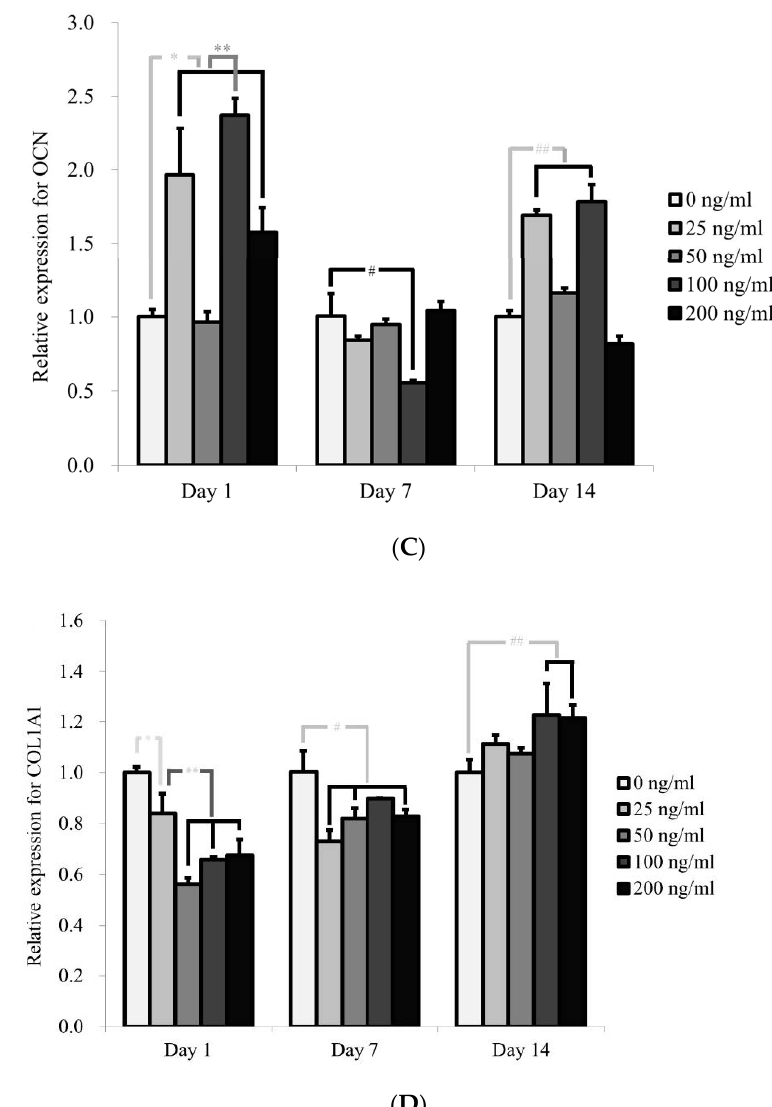
Figure 7. ( A ) Quantification of expression of RUNX2 mRNA by real-time polymerase chain reaction on Days 1, 7, and 14. * p < 0.05 vs. the 0 ng/mL group on Day 7. ** p < 0.05 vs. the 100 ng/mL group on Day 7. # p < 0.05 vs. the 0 ng/mL group on Day 14. ## p < 0.05 vs. the 200 ng/mL group on Day 14. ( B ) Quantification of expression of BSP mRNA by real-time polymerase chain reaction on Days 1, 7, and 14. * p < 0.05 vs. the 0 ng/mL group on Day 1. ** p < 0.05 vs. the 0 ng/mL group on Day 7. # p < 0.05 vs. the 100 ng/mL group on Day 7. ## p < 0.05 vs. the 25 ng/mL group on Day 7. † p < 0.05 vs. the 0 ng/mL group on Day 14. †† p < 0.05 vs. the 200 ng/mL group on Day 14. ‡ p < 0.05 vs. the 100 ng/mL group on Day 14. ( C ) Quantification of expression of OCN mRNA by real-time polymerase chain reaction on Days 1, 7, and 14. * p < 0.05 vs. the 0 ng/mL group on Day 1. ** p < 0.05 vs. the 100 ng/mL group on Day 7. # p < 0.05 vs. the 0 ng/mL group on Day 7. ## p < 0.05 vs. the 0 ng/mL group on Day 14. ( D ) Quantification of expression of COL1A1 mRNA by real-time polymerase chain reaction on Days 1, 7, and 14. * p < 0.05 vs. the 0 ng/mL group on Day 1. ** p < 0.05 vs. the 25 ng/mL group on Day 7. # p < 0.05 vs. the 0 ng/mL group on Day 7. ## p < 0.05 vs. the 0 ng/mL group on Day